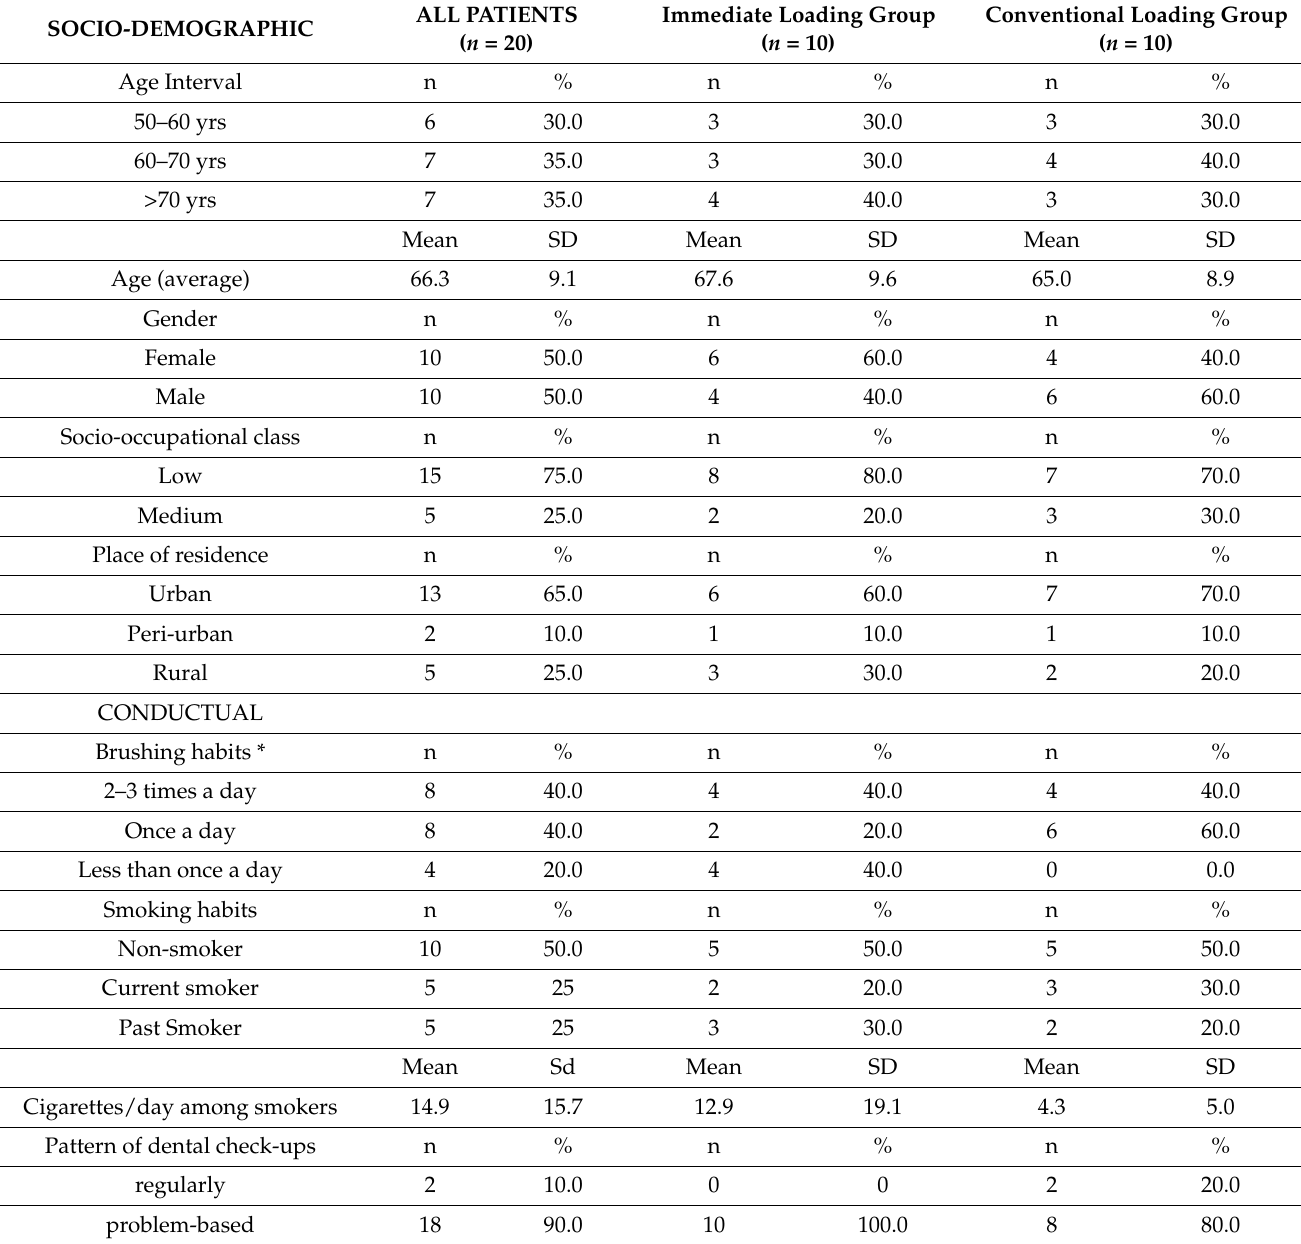
Table 1. Socio-demographic and conductual description of the study sample ( n = 20) and within implant groups. ALL PATIENTS SOCIO-DEMOGRAPHIC ( n =